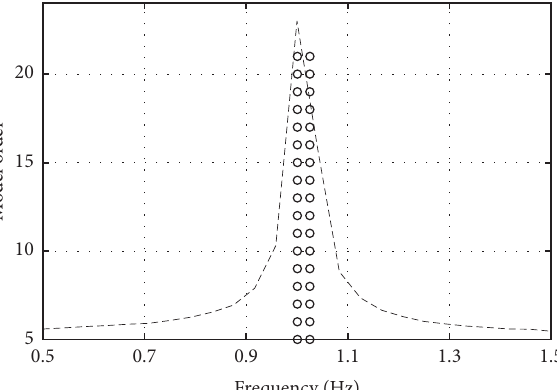
Figure 12: Variation of the identified frequencies with model